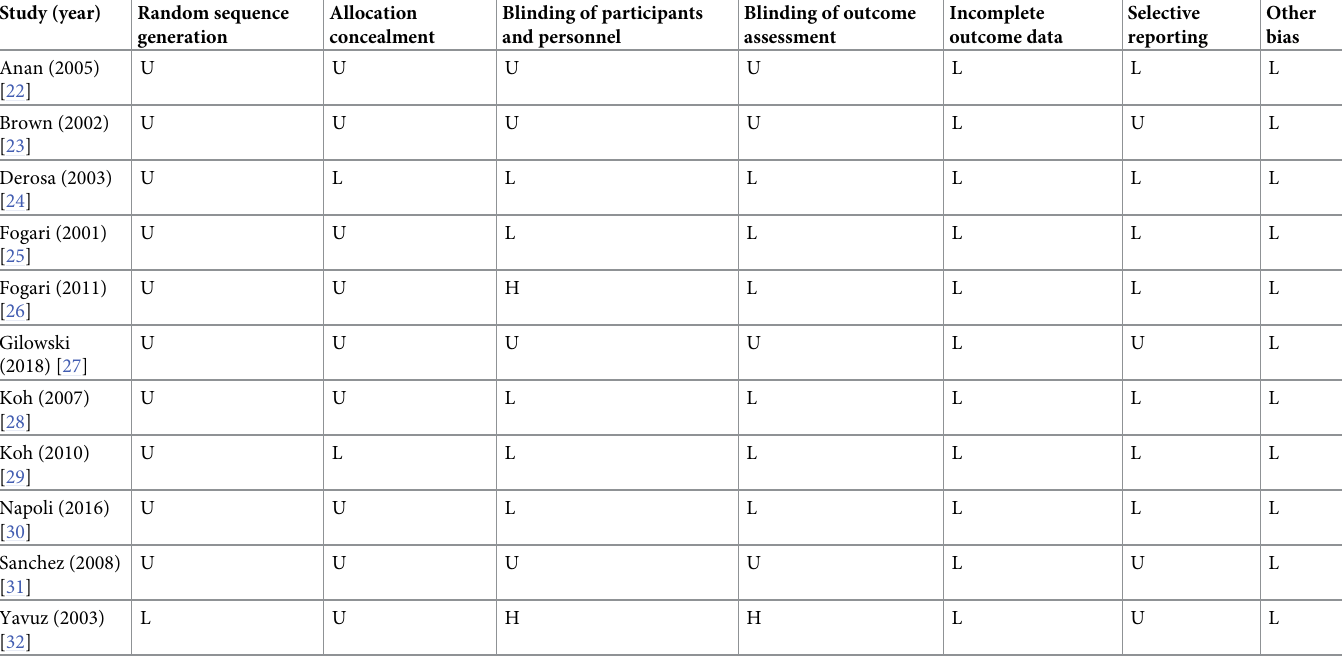
Table 3. Risk of bias assessment in the included studies.